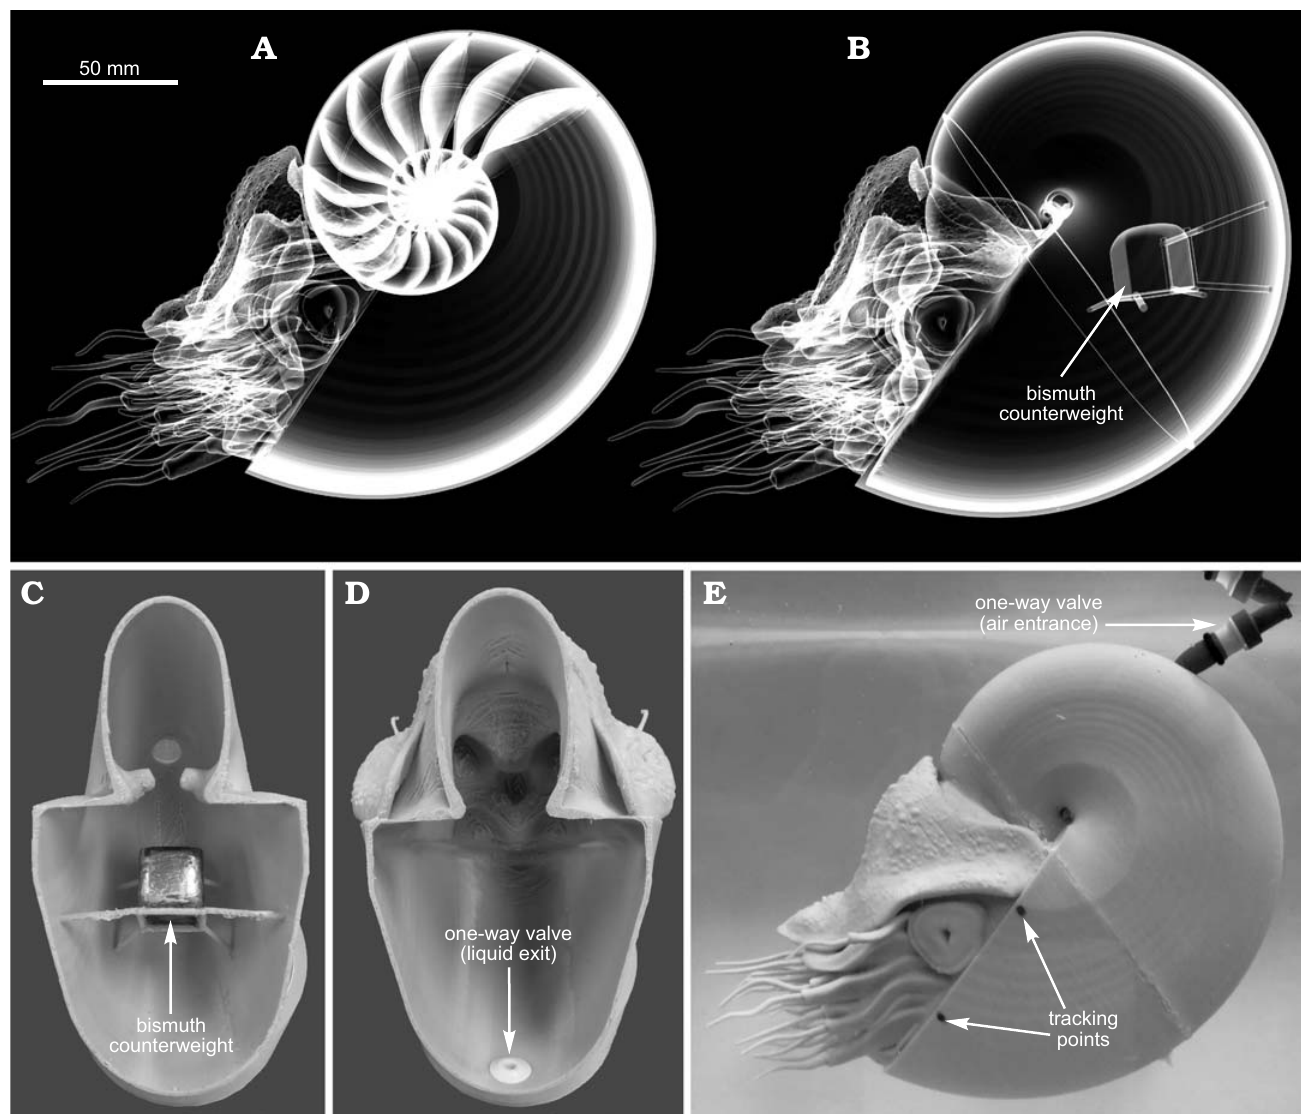
Fig. 4. Generation of a 3D printed model of Nautilus pompilius with theoretically equal physical properties to the virtual counterparts. A . Original virtual model from Peterman et al. (2019: fig. 2.5). B . Modified virtual model with simplified internal geometry. The center of buoyancy remains the same be- cause external geometry does not change. The total center of mass, however, is corrected by a bismuth counterweight of known volume, density, and mass. C . 3D printed posterior half of the physical model with bismuth counterweight in the computed position. D . Anterior half of the physical model showing the one-way valve for liquid to exit upon displacement by an air-filled balloon. E . Neutrally buoyant physical model with the required volume to liquid ratio for neutral buoyancy. This computed volume of air is inserted through a one-way entrance valve into the internal balloon. Tracking points are placed parallel to the aperture in order to analyze movement in a hydrodynamic